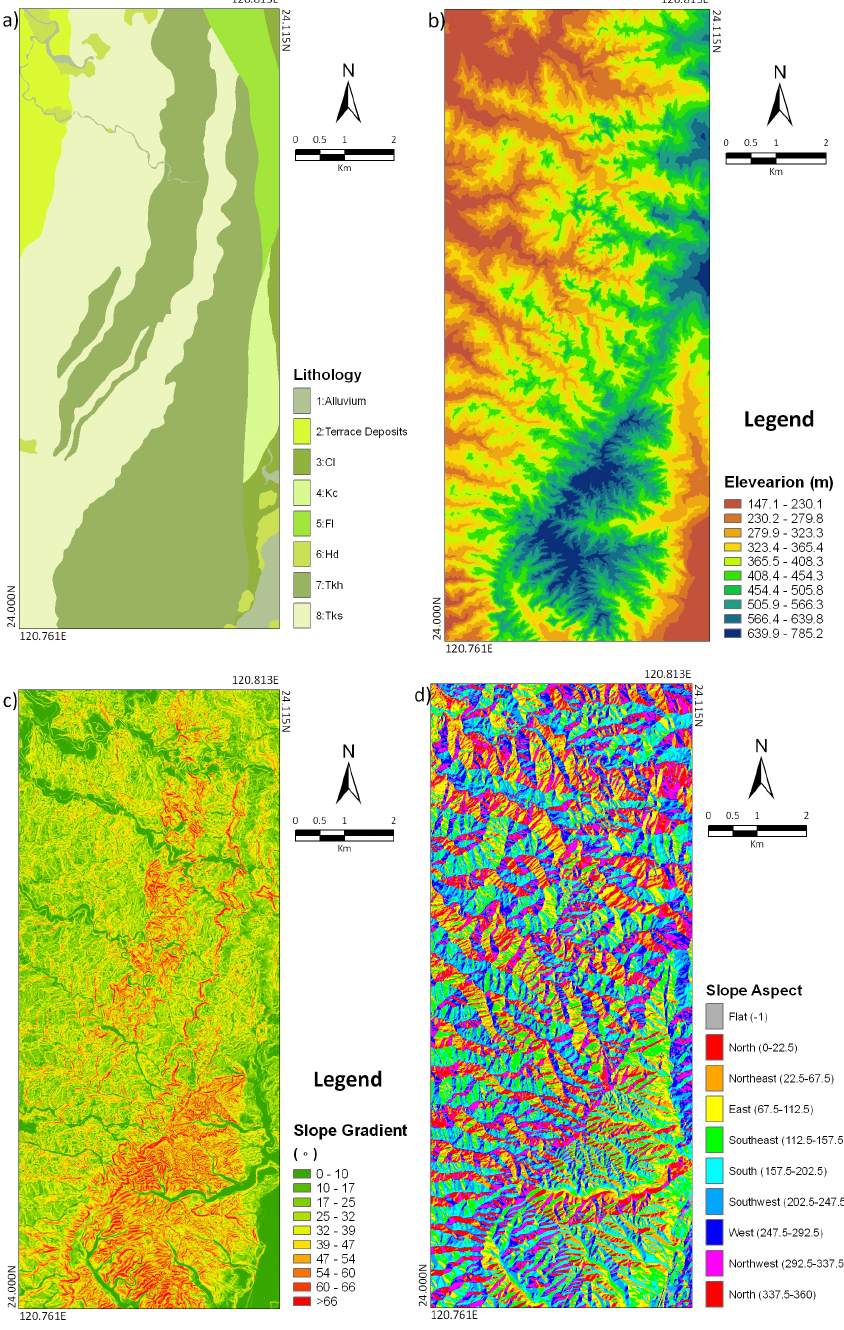
Fig. 6. Spatial distribution of factors: (a) lithologic unit, (b) elevation, (c) slope gradient map, (d) slope aspect map, (e) terrain roughness, (f) land-cover map.